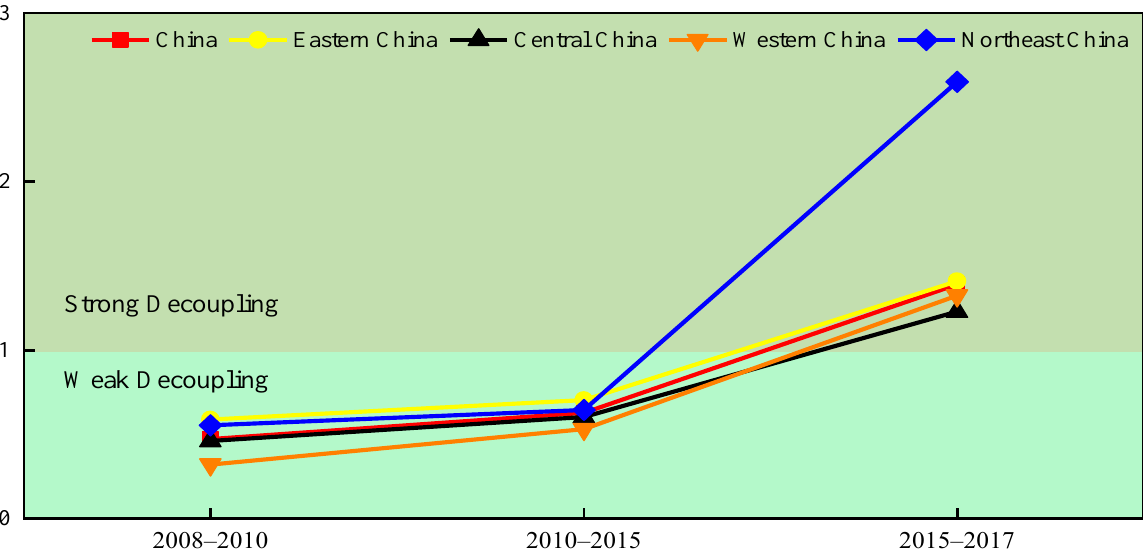
2.5 emissions in the medium